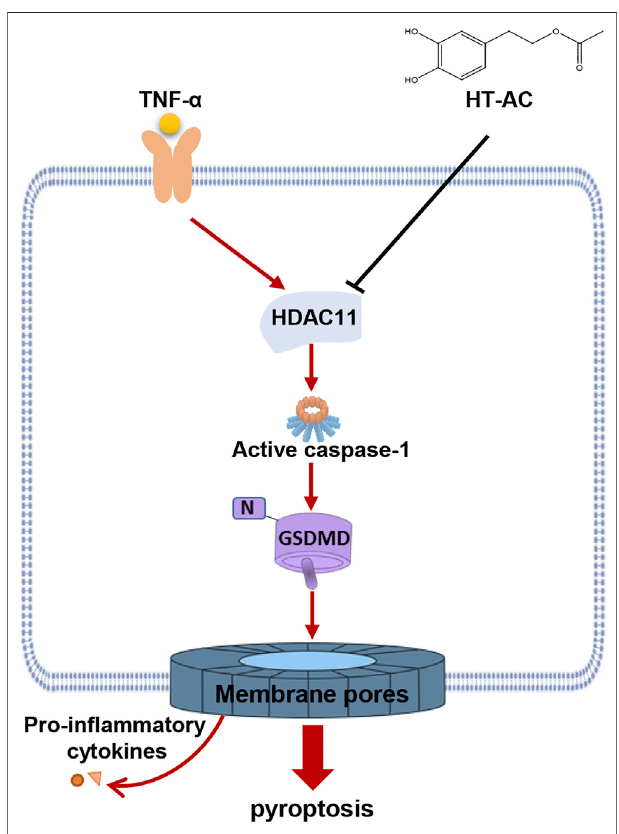
FIGURE 7 | Schematic illustration of the signaling pathway involved in the effect of HT-AC on pyroptosis in HUVECs.